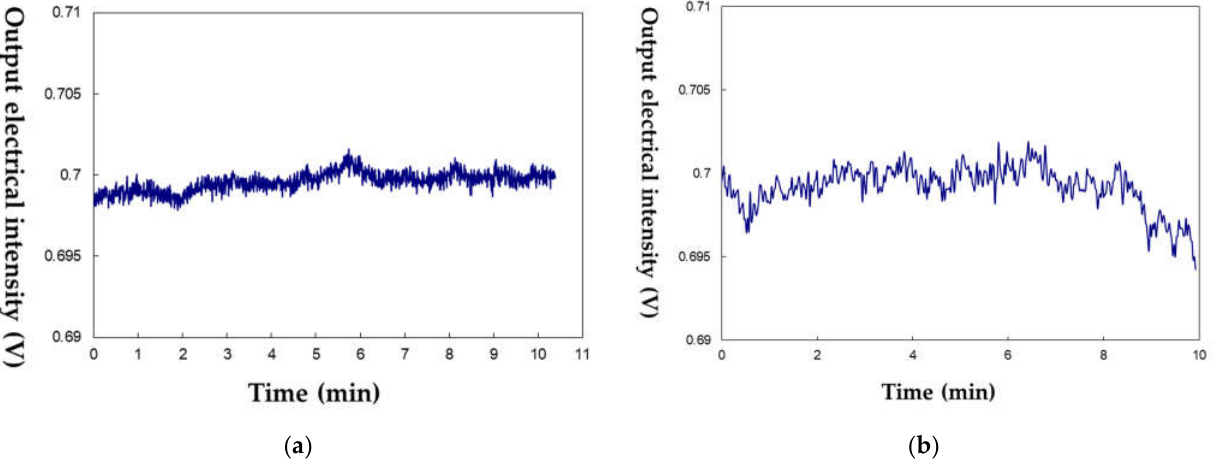
Figure 6. Optical power stability tests for the experimental light source outputted with relative electrical voltage in ( a ) a short-term test and ( b ) a long-term test as I S = 100 mA.